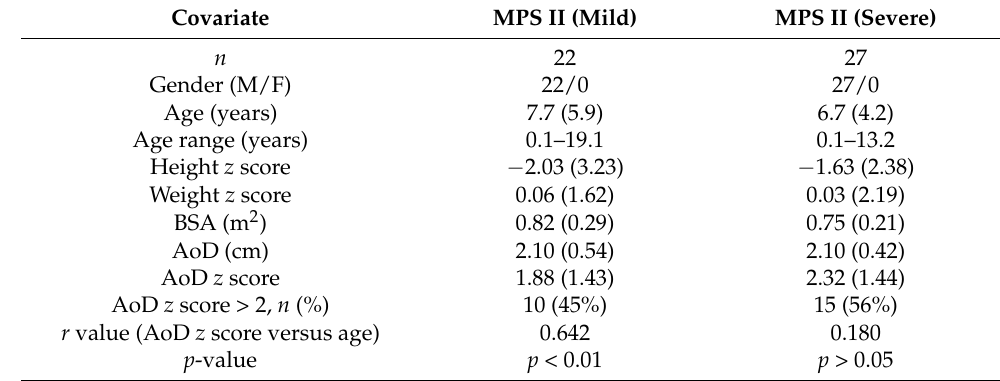
Figure 4. Aortic root diameter z score in the patients with the mild and severe forms of MPS II ( p = 0.287).